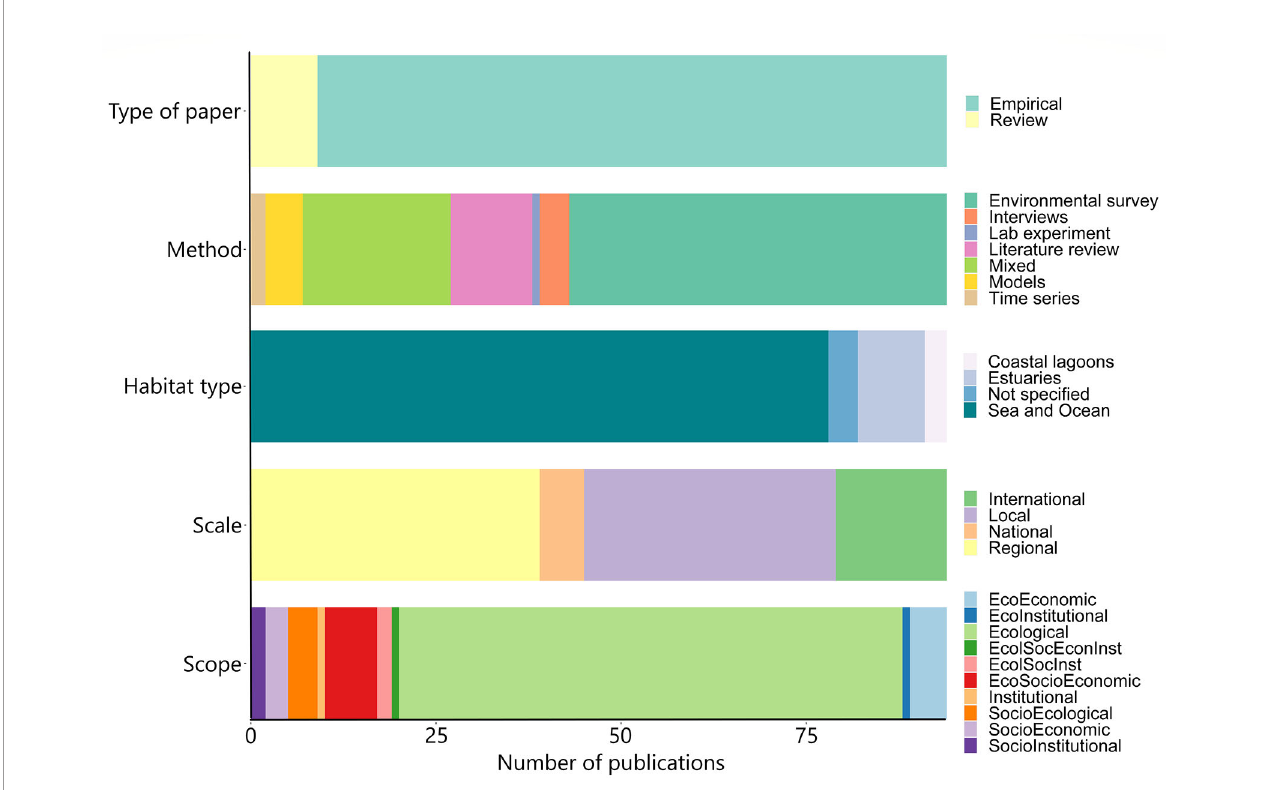
FIGURE 2 | Number of publications considered in each variable category from the literature review